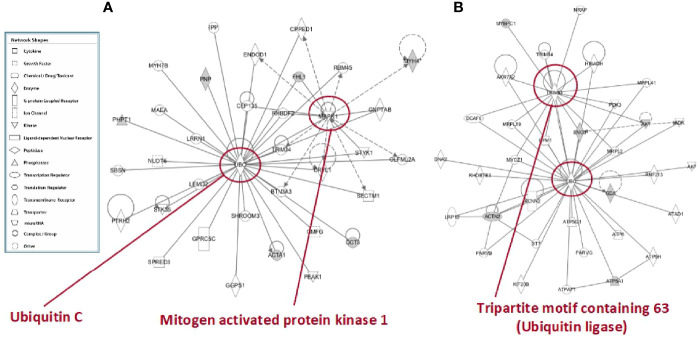

In silico analysis of interconnections between differentially represented proteins in tibialis anterior (A) and soleus (B) muscles upon RF vs. SS comparison. Gene products are represented as nodes, and the biological relationship between two nodes is represented as an edge (line). Indirect interactions appear as broken lines, whereas direct interactions appear as solid lines. All edges shown are supported by at least 1 reference from the literature, from a textbook, or from canonical information stored in the Ingenuity Pathways Knowledge Base (IPKB). Human, mouse, and rat orthologues of a gene are stored as separate objects in IPKB but are represented as a single node in the network. For clarity, network shapes are shown. In A: ACTA1, actin, alpha skeletal muscle; BTN3A3, utyrophilin subfamily 3 member A3; CCT3, T-complex protein 1 subunit gamma; CEP135, centrosomal protein 135; CPPED1, serine/threonine-protein phosphatase; CRYL1, lambda-crystallin homolog; ENDOD1, endonuclease domain containing protein 1; GGPS1, geranylgeranyl pyrophosphate synthase; GMFG, glia maturation factor gamma; GNPTAB, N-acetylglucosamine-1-phosphate transferase subunits alpha and beta; GPRC5C, G-protein coupled receptor family C group 5 member C; IPP, actin-binding protein IPP; LEMD2, LEM domain containing 2; LRRN1, leucine-rich repeat neuronal protein 1; MAEA, E3 ubiquitin-protein transferase MAEA; MYH4, myosin heavy chain 2. MYH7B, myosin heavy chain 7B; NUDT6, nucleoside diphosphate-linked moiety X motif 6; OLFML2A, olfactomedin-like 2A; PEAK1, pseudopodium-enriched atypical kinase 1; PHPT1, 14 kDa phosphohistidine phosphatase; PNP, purine nucleoside phosphorylase; PTRH2, peptidyl-tRNA hydrolase 2; RBM45, RNA-binding protein 45; RHBDF2, rhomboid 5 homolog 2; SBSN, suprabasin; SECTM1, secreted and transmembrane 1; SHROOM3, shroom family member 3; SPRED3, sprouty-related, EVH1 domain-containing 3; STK35, serine/threonine kinase 35; STYK1, serine/threonine/tyrosine kinase 1; TRIM34, tripartite motif-containing 34; UBC, ubiquintin (C) In B: ACTN2, actinin alpha 2; ADK, adenosine kinase; AK1, adenylate kinase isoenzyme 1; AK7, adenylate kinase 7; AKR7A2, aflatoxin B1 aldehyde reductase member 2; ATP5A1, ATP synthase, mitochondrial F1 complex, alpha subunit 1; ATP5G1, ATP synthase F(0) complex subunit C1, mitochondrial; ATP5H, ATP synthase subunit d, mitochondrial; ATP6, ATP synthase subunit a; ATPAF1, ATP synthase mitochondrial F1 complex assembly factor 1; ATPD1, ATPase family AAA domain-containing protein 1; DCAF6, DDB1 and CUL4-associated factor 6; DNA2, DNA replication ATP-dependent helicase/nuclease; ENO3, beta-enolase; GDA, guanine deaminase; GFM1, elongation factor G, mitochondrial; HIBADH, 3-hydroxyisobutyrate dehydrogenase, mitochondrial; KCNN2, small conductance calcium-activated potassium channel protein 2; KIF20B, kinesin family member 20B; LRP12, LDL receptor-related protein 12; MRPL19, mitochondrial ribosomal protein L19; MRPL2, 39S ribosomal protein L2, mitochondrial; MRPL2, 39S ribosomal protein L2, mitochondrial; MRPL41, 39S ribosomal protein L41, mitochondrial; MYBPC1, myosin-binding protein C, slow-type; MYOZ1, myozenin 1; NRAP, nebulin-related-anchoring protein; PARVB, parvb protein; PARVG, parvin; PDK3, protein-serine/threonine kinase; RHOBTB3, Rho-related BTB domain containing 3 (predicted), isoform CRA_b; RNF213, ring finger protein 213; ST7, suppressor of tumorigenicity 7 protein; TRIM54, tripartite motif-containing protein 54; TRIM63, E3 ubiquitin-protein ligase; UBC, ubiquintin C.